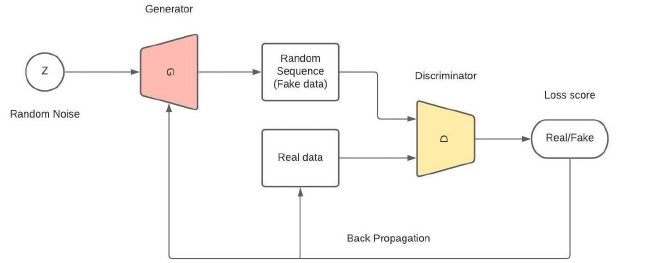
Figure 1. Traditional GAN